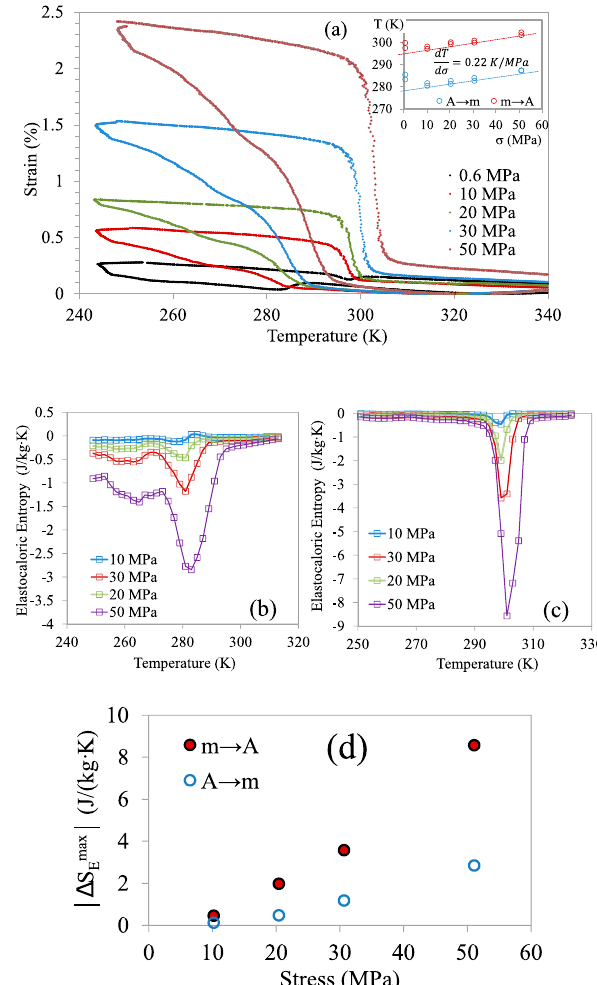
Figure 10. ( a ) ε ( T ) curves under constant loads; the evolution of the transformation temperatures vs. applied stress is shown in the inset. Temperature dependence of the isothermal entropy change for di ff erent loads on cooling ( b ) and heating ( c ). ( d ) Maximum absolute values of the elastocaloric entropy change as a function of applied stress.